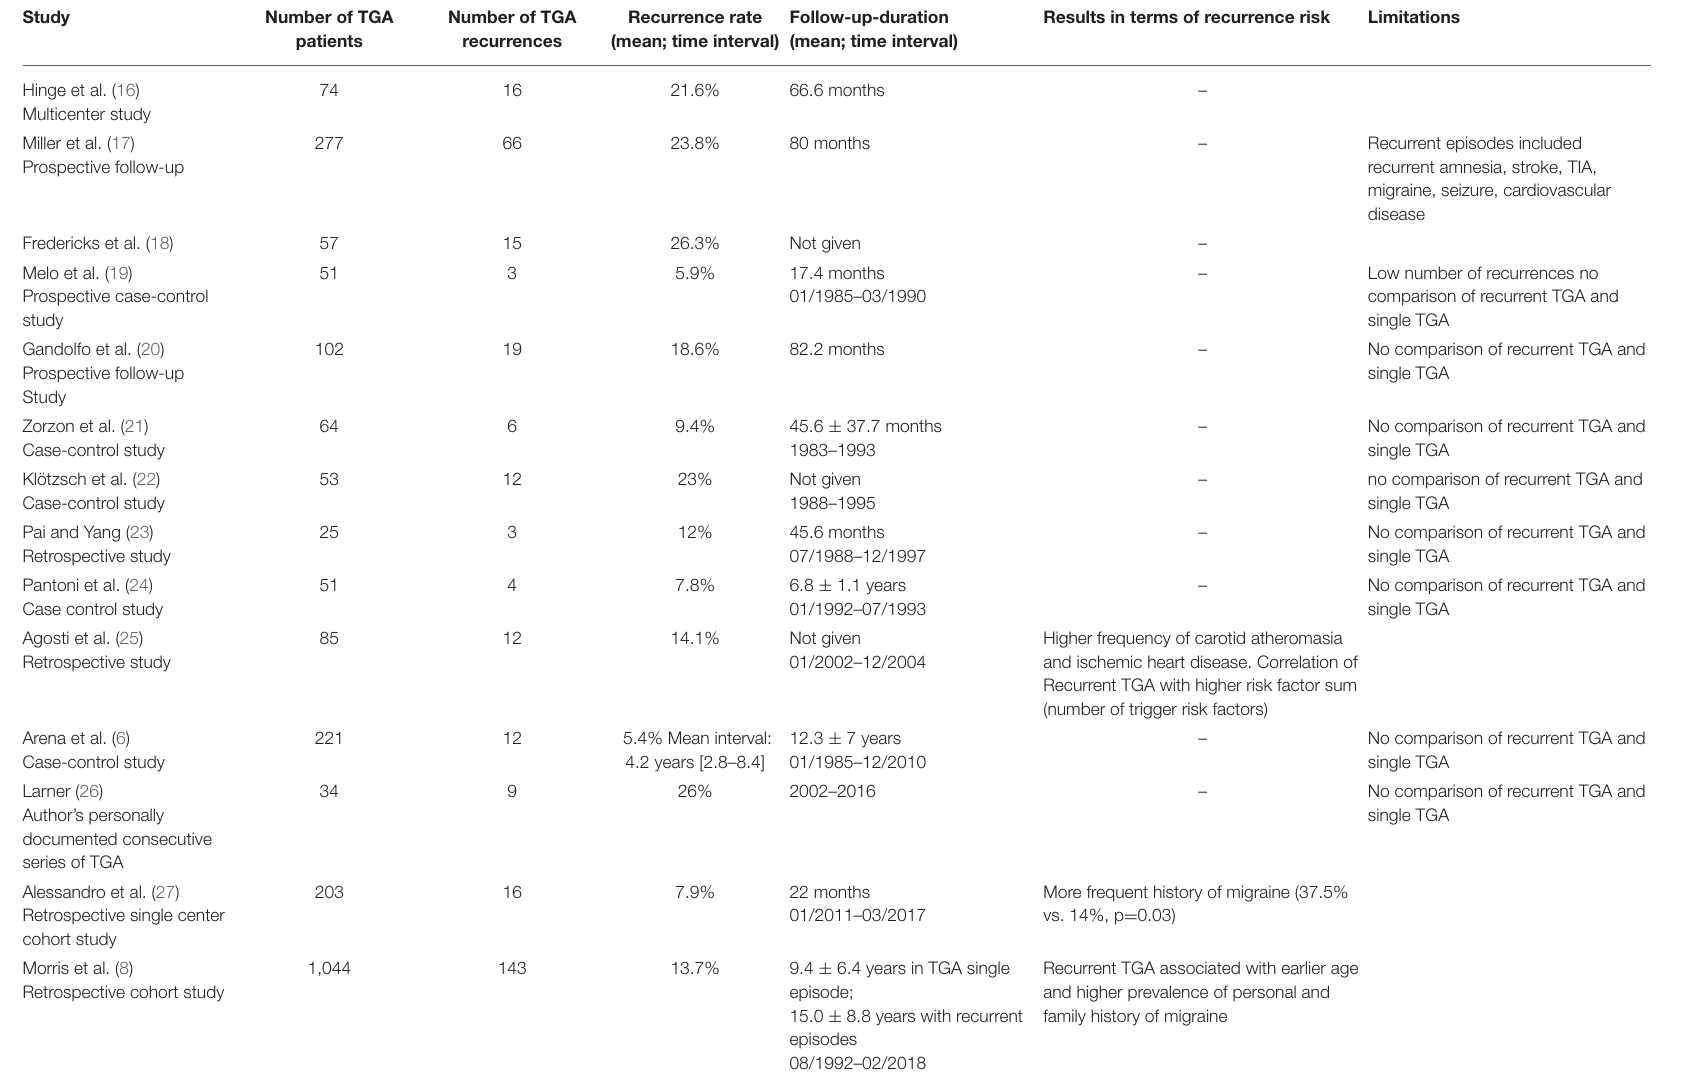
TABLE 2 | Studies and reports on TGA patients with TGA